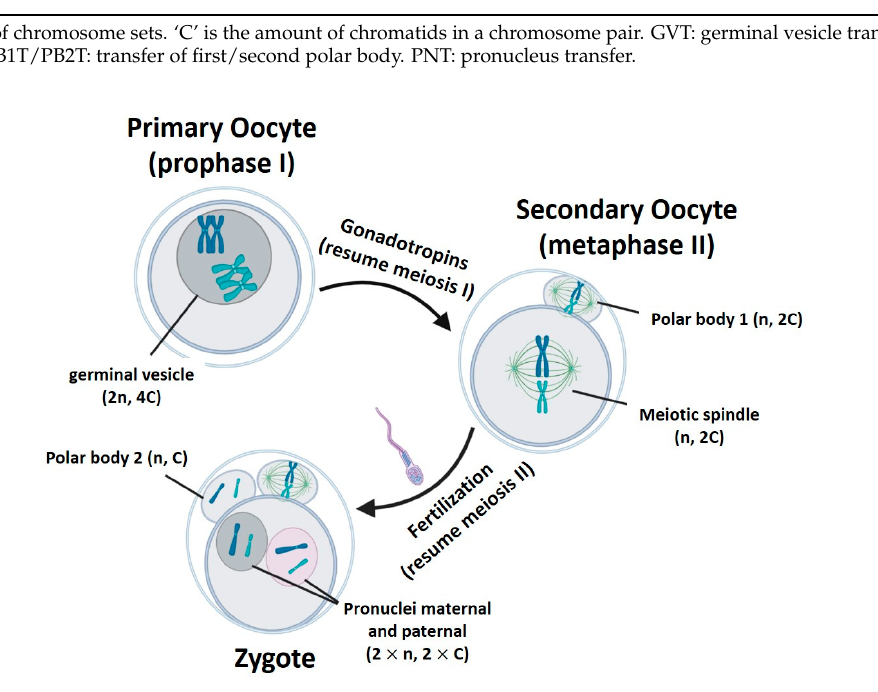
Figure 1. Gametogenesis process. n represents the number of chromosome sets. C is the amount of chromatids in a chromosome pair. Created with BioRender.com